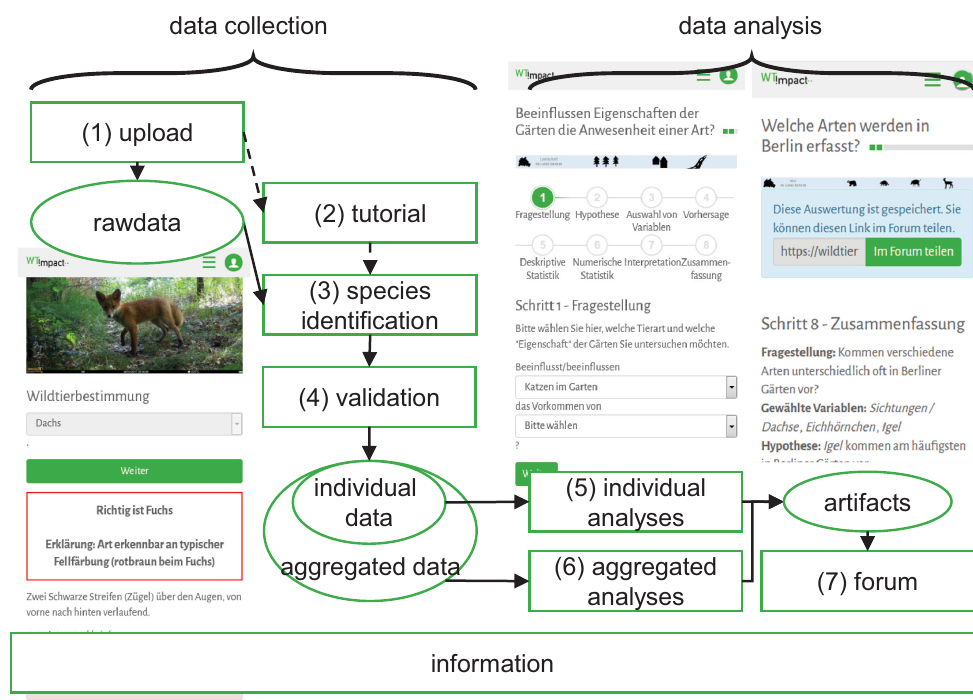
Fig 1. Flow chart of scientific activities and resources (rectangular boxes) as well as data and artifacts (oval boxes) in the project.